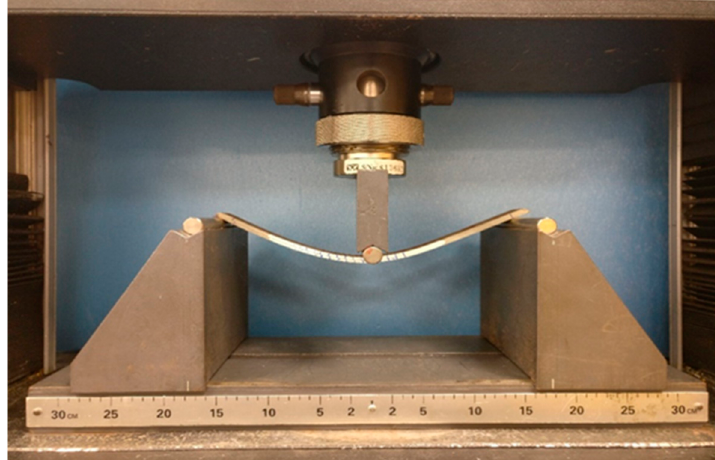
Figure 7. ENF specimen under test. Mixed-Mode I/II interlaminar fracture toughness, Gc, of all the batches of composites was determined using MMB specimens. In this test, both opening, as well as sliding of both the top and bottom surfaces of the specimens, occur. It is a combination of both the DCB and ENF tests. A non-adhesive insert was placed on the midplane to act as a delamination initiator. Piano hinges bonded to one end of the specimen were used to apply opening forces per- pendicular to the specimen face avoiding any moment at the point of loading. A uniform displacement rate of 1 mm/min was set for all the specimens so that steady crack propa- gation was ensured. The MMB specimen under test and the schematic of the specimen are shown in Figure 8 and Figure 9 respectively. Figure 8. MMB specimen under test.